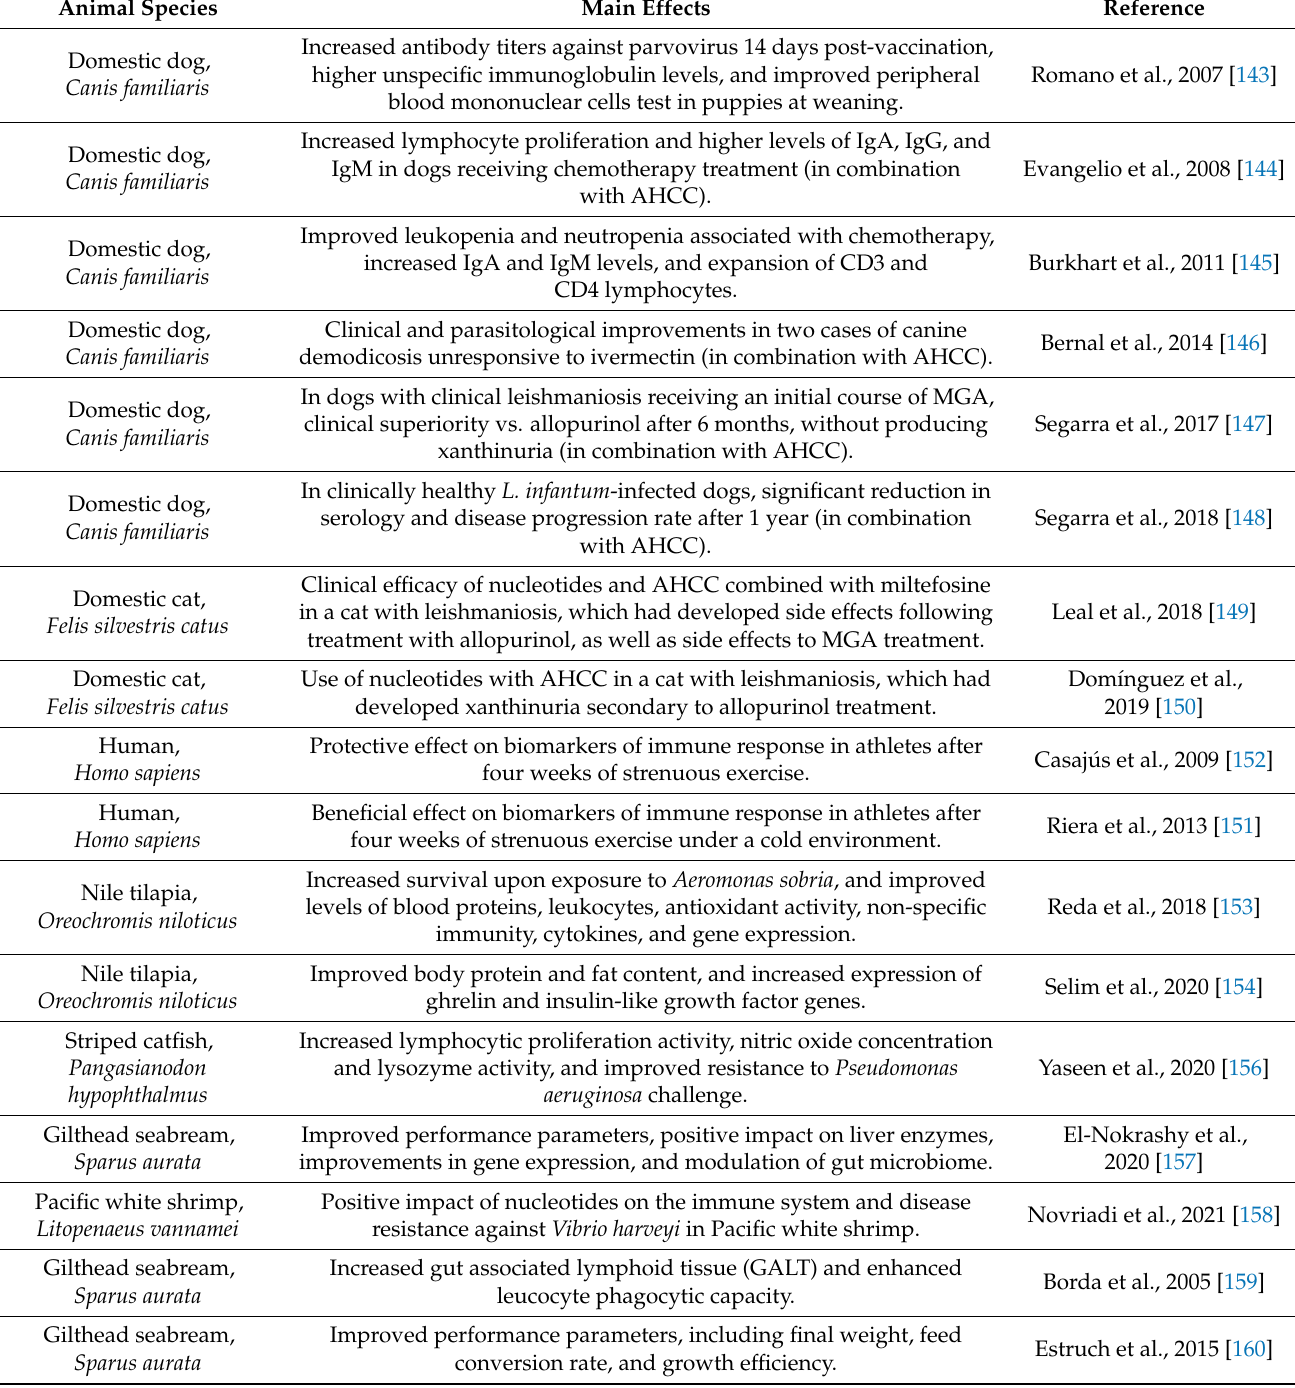
Table 1. Scientific literature reports the in vivo immunomodulatory activity and health benefits provided by the oral administration of the nucleotide-rich yeast extract Nucleoforce ® in several animal species. Animal